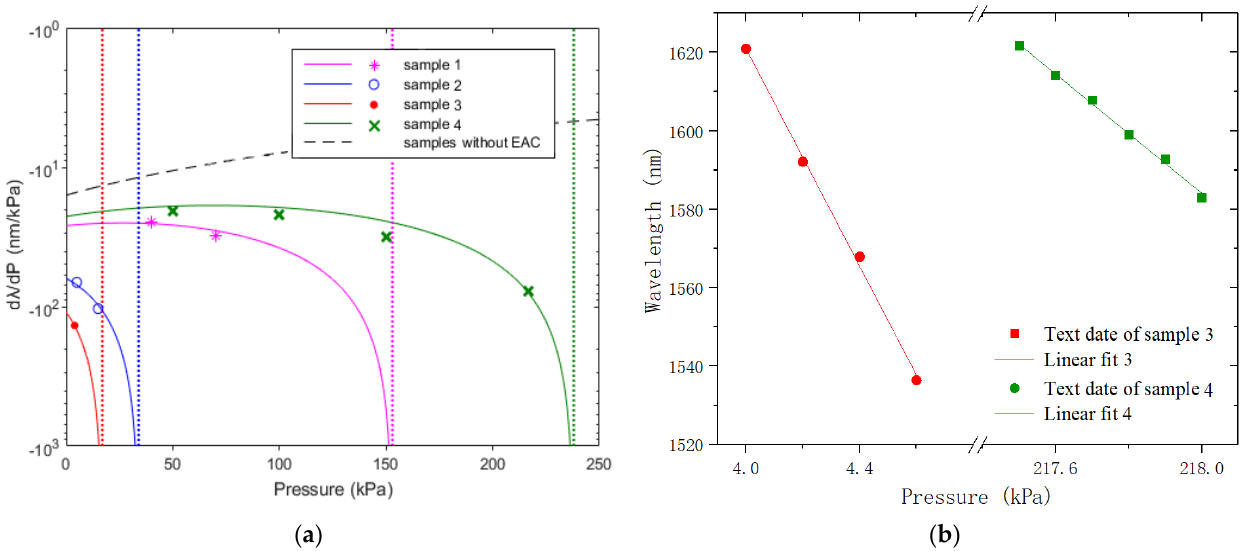
Figure 6. ( a ) Simulation and experimental results of dλ / dP at different pressure levels; ( b ) wavelength-shift sensitivities of sample-3 and sample-4.